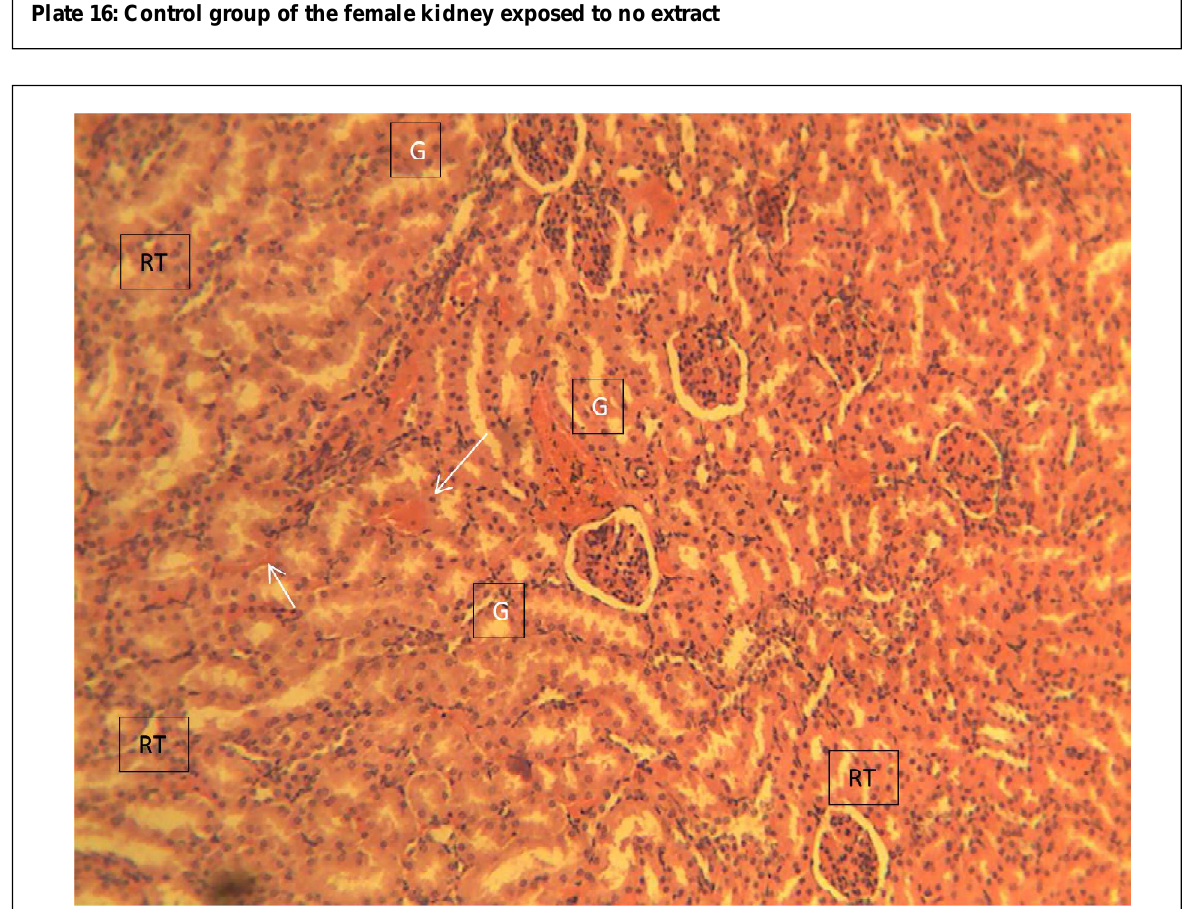
Plate 17: Female kidney of the group exposed to 200 mg/kg of aqueous